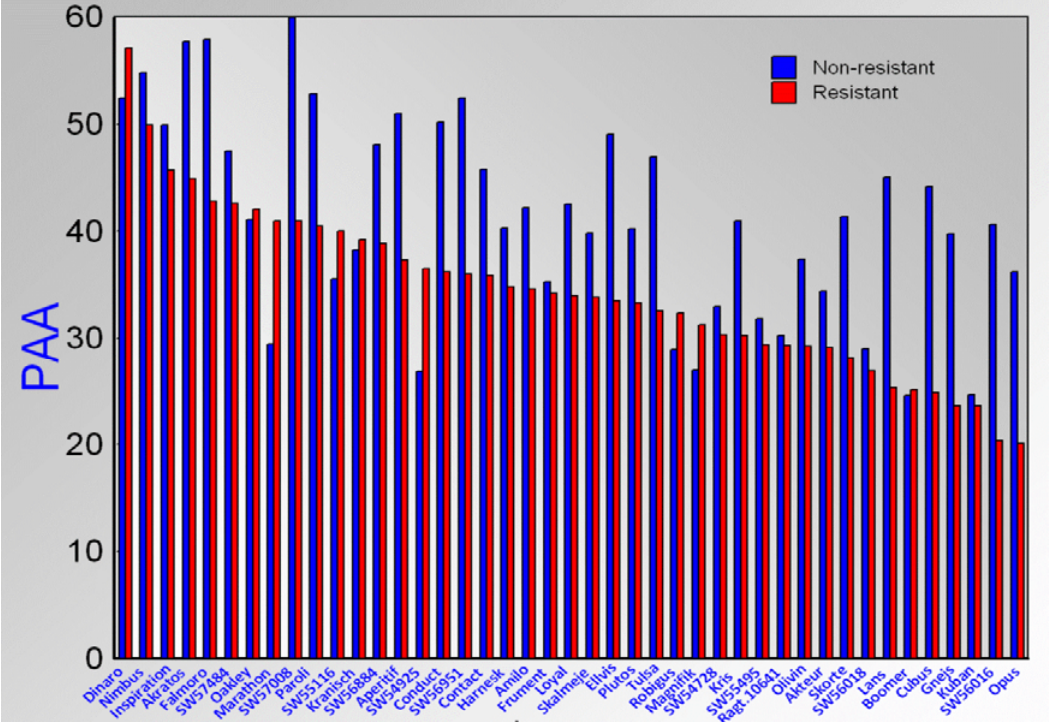
Figure 1. Potential allelopathic activity (PAA) calculated as percentage reduction in root growth of herbicide-resistant and herbicide-sensitive black-grass in the presence of 32 winter wheat cultivars and eight advanced breeding lines, two triticale cultivars (Dinaro and Falmaro) and one rye cultivar (Amilo) (95% confidence interval =